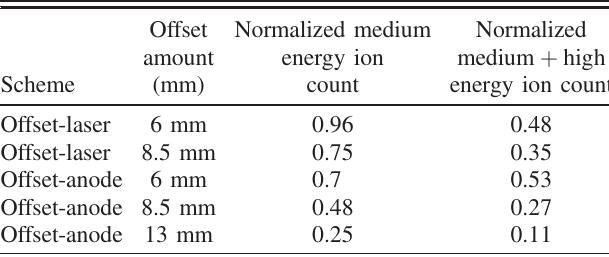
TABLE II. Normalized ion counts under the laser spot for all offset laser and anode cases. Ion counts for each case and energy range was normalized to that of the on-axis